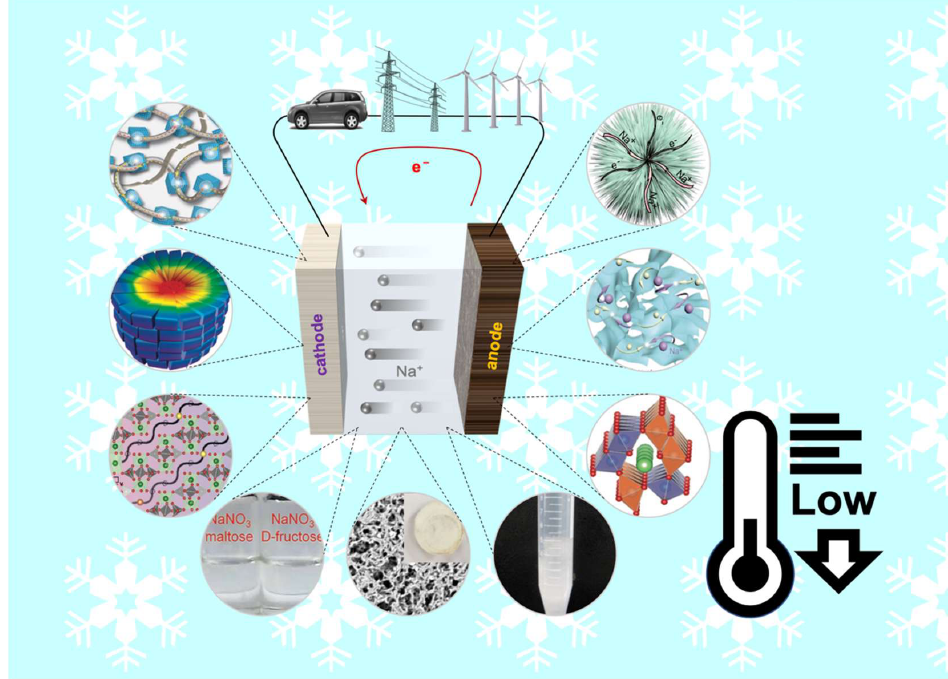
Figure 1. Schematic diagram of sodium-ion battery at low temperatures.